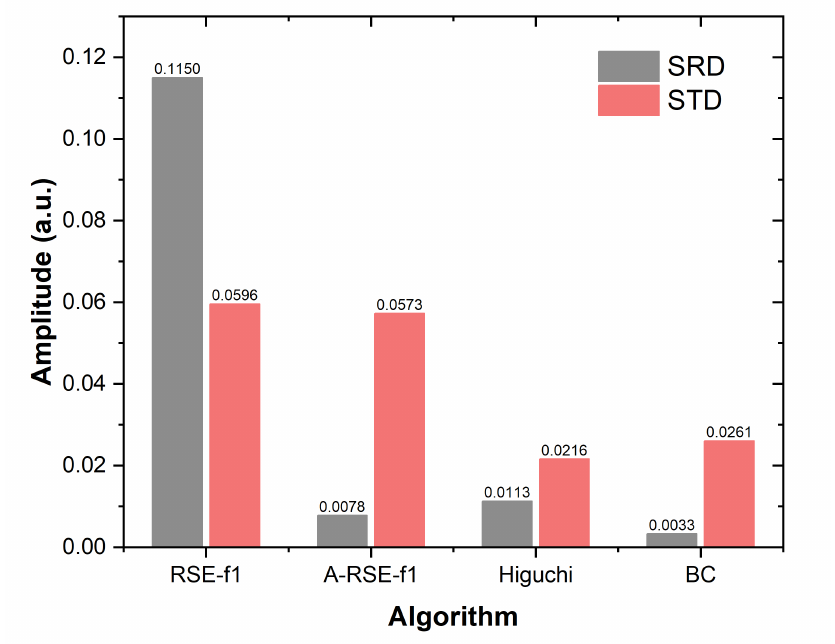
Figure 7. The single running Duration (SRD) and standard deviation (STD) of the RSE-f1, A-RSE-f1, Higuchi, and BC